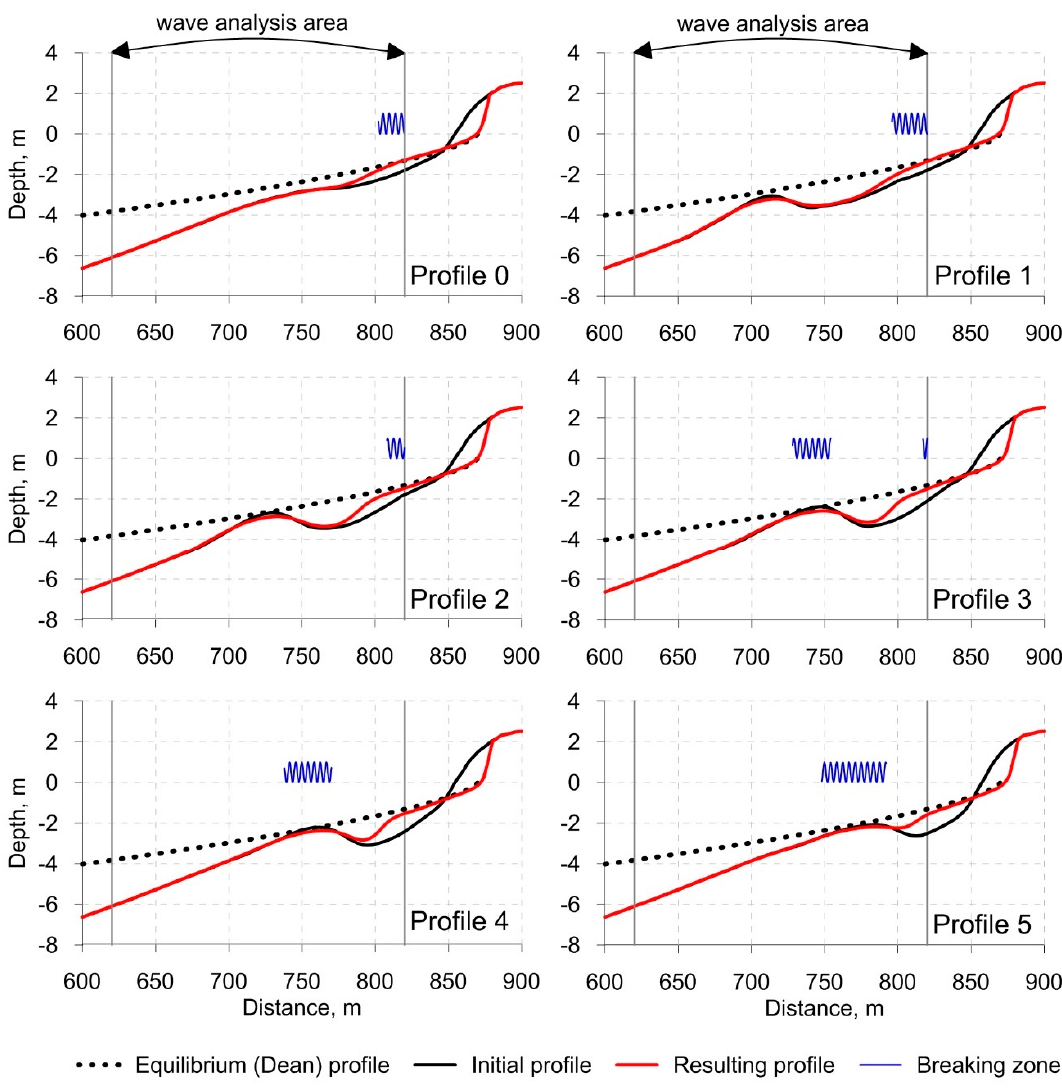
Figure 4. Initial and resulting profiles after 20 h of wave action (Hs = 1.5 m, Tp = 10.5 s), location of the breaking zone, and theoretical shape of the equilibrium profile calculated for a grain size of 0.2 mm.